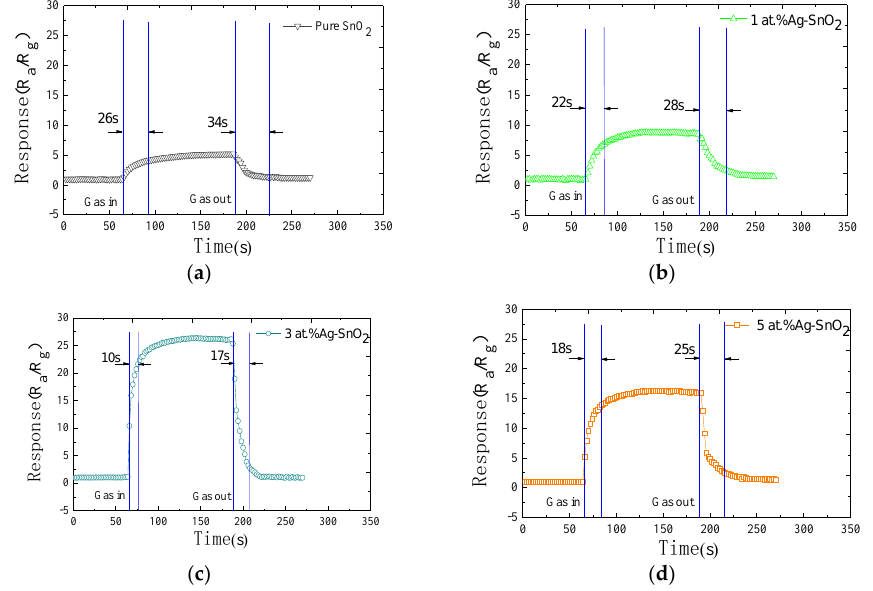
Figure 8. Response-recovery curves of the as-prepared sensors to 50 µL/L H 2 at their own optimum operating temperature : ( a ) pure SnO 2 sensor; ( b ) 1 at.% Ag-doped SnO 2 sensor; ( c ) 3 at.% Ag-doped SnO 2 sensor; ( d ) 5 at.% Ag-doped SnO 2 sensor.